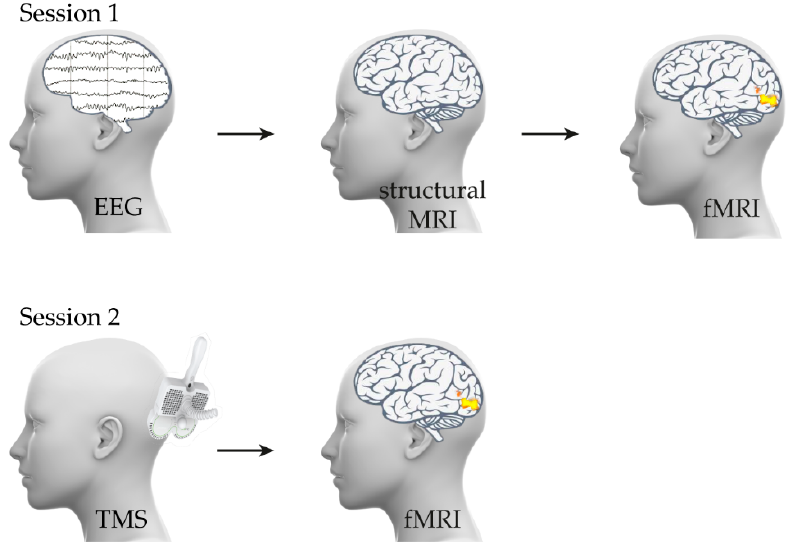
Figure 1. Scheme of